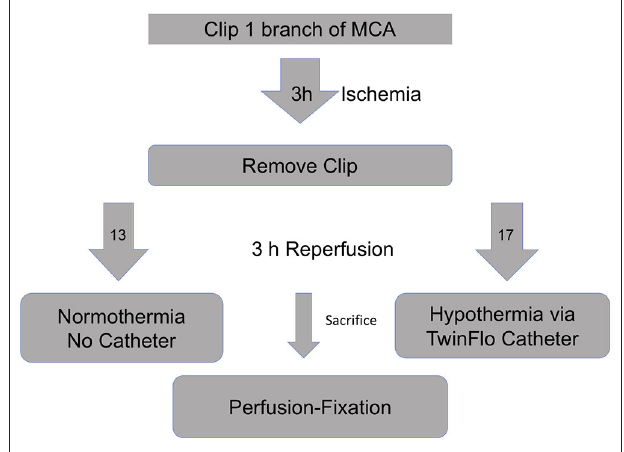
FIGURE 1 | Schematic of the experiment.